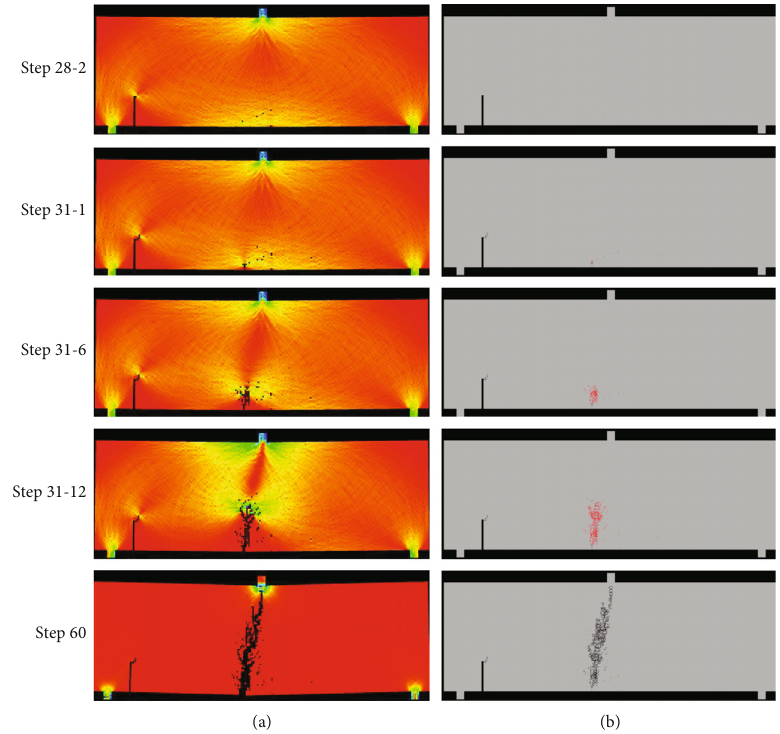
Figure 5: The failure process of a = 80 mm beam: (a) the stress cloud diagram; (b) the acoustic emission